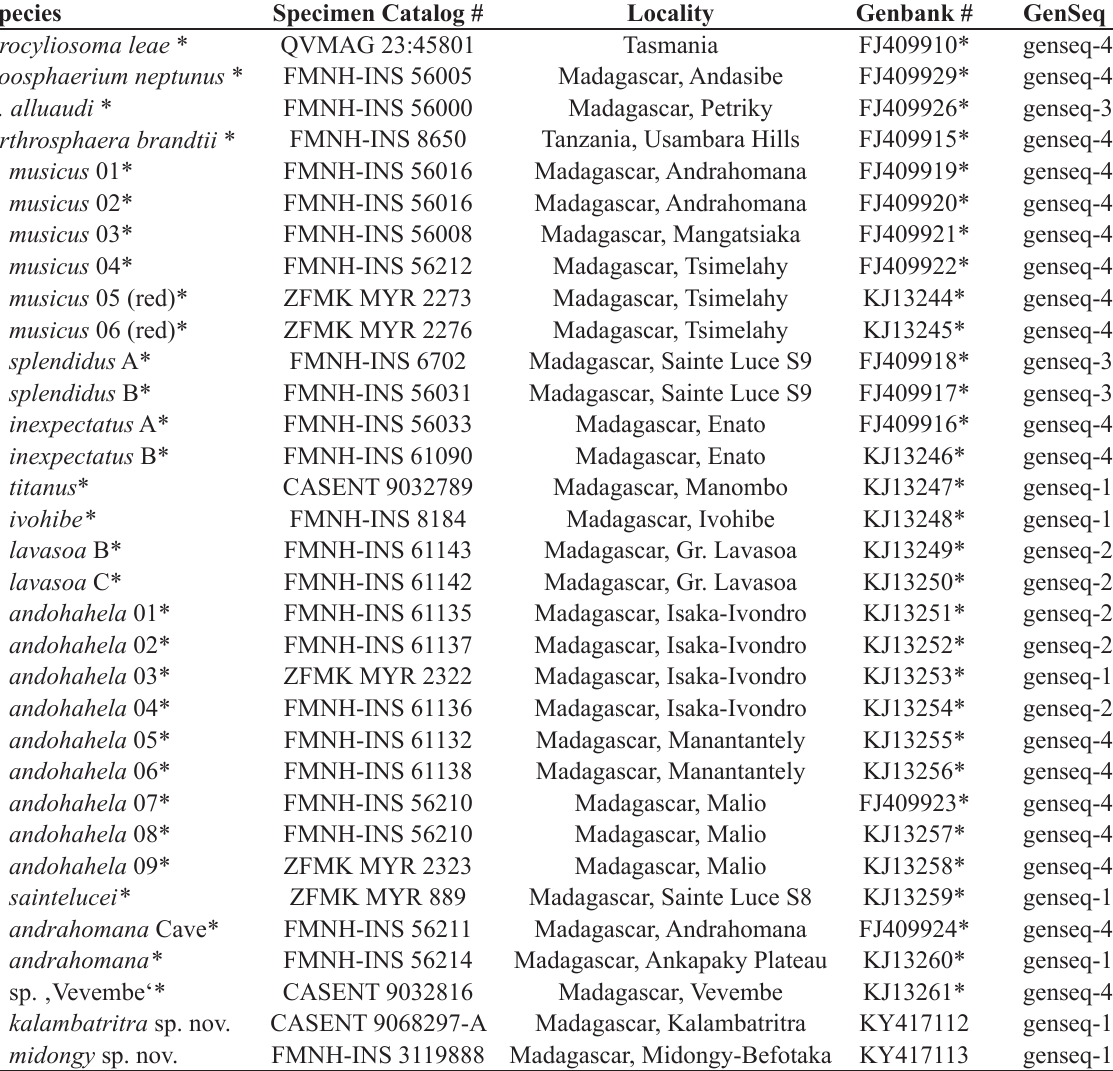
European Journal of Taxonomy 381: 1–25 Table 1. Samples of species of Sphaeromimus de Saussure & Zehntner, 1902, depository, locality, Genbank code, and reliability of the taxonomic identification of the sampled specimen (GenSeq). Genbank numbers marked by asterisk (*) were published in previous studies (Wesener et al . 2010, 2014).